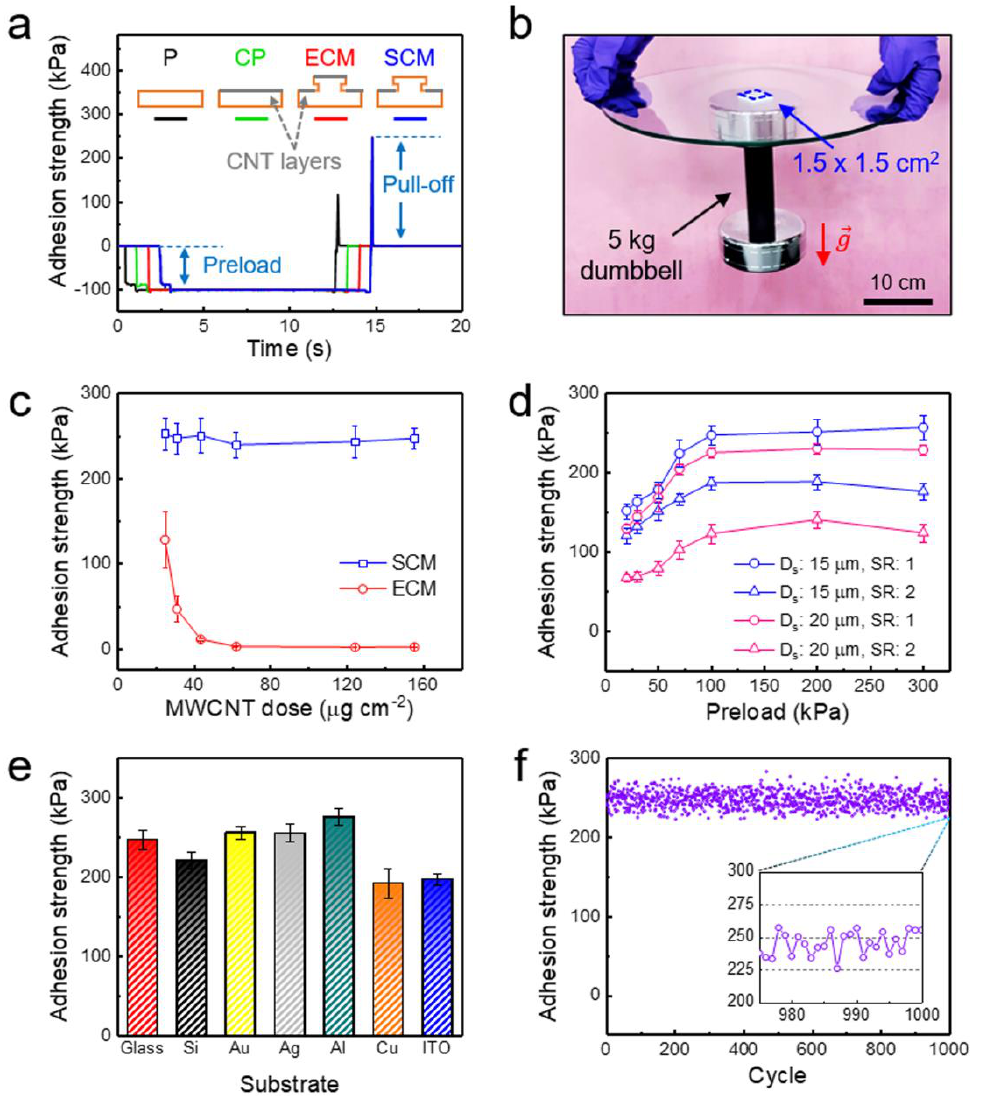
Figure 2. Adhesion behavior of the strain sensor. ( a ) Measured adhesion strengths of the planar polydimethylsiloxane (PDMS; P), MWCNT-coated planar PDMS (CP), entirely MWCNT-coated PDMS micropillars (ECM), and selectively MWCNT-coated PDMS micropillars (SCM) (preload: 100 kPa, pulling rate: 1 mm s − 1 ). ( b ) Photograph showing a 5 kg dumbbell attached to a glass plate via the self-attachable strain sensor (area: 1.5 × 1.5 cm 2 ). ( c ) Adhesion strengths of the ECM and SCM sensors as a function of coating dose of the MWCNTs (preload: 100 kPa, pulling rate: 1 mm s − 1 ). ( d ) Adhesion strengths of the SCM sensors with di ff erent pillar stem diameters ( D s : 15 and 20 µ m; spacing ratio (SR): 1 and 2). ( e ) Adhesion strengths of the SCM sensors with a pillar D s of 15 µ m and an SR of 1 against di ff erent substrates (preload: 100 kPa, pulling rate: 1 mm s − 1 ). Error bars in ( c – e ) represent the standard deviations, and each test was repeated 10 times. ( f ) Adhesion durability of the SCM sensor after repeated cycles of attachment and detachment.